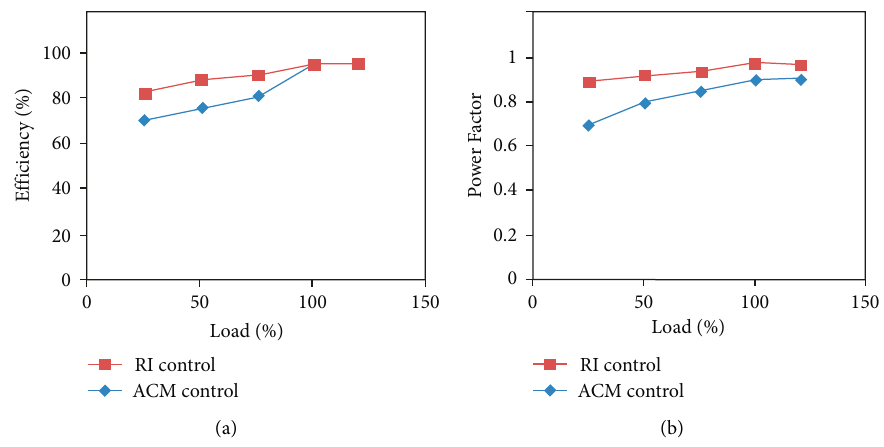
Figure 13: (a) Total harmonic distortion vs output power (%) for V load